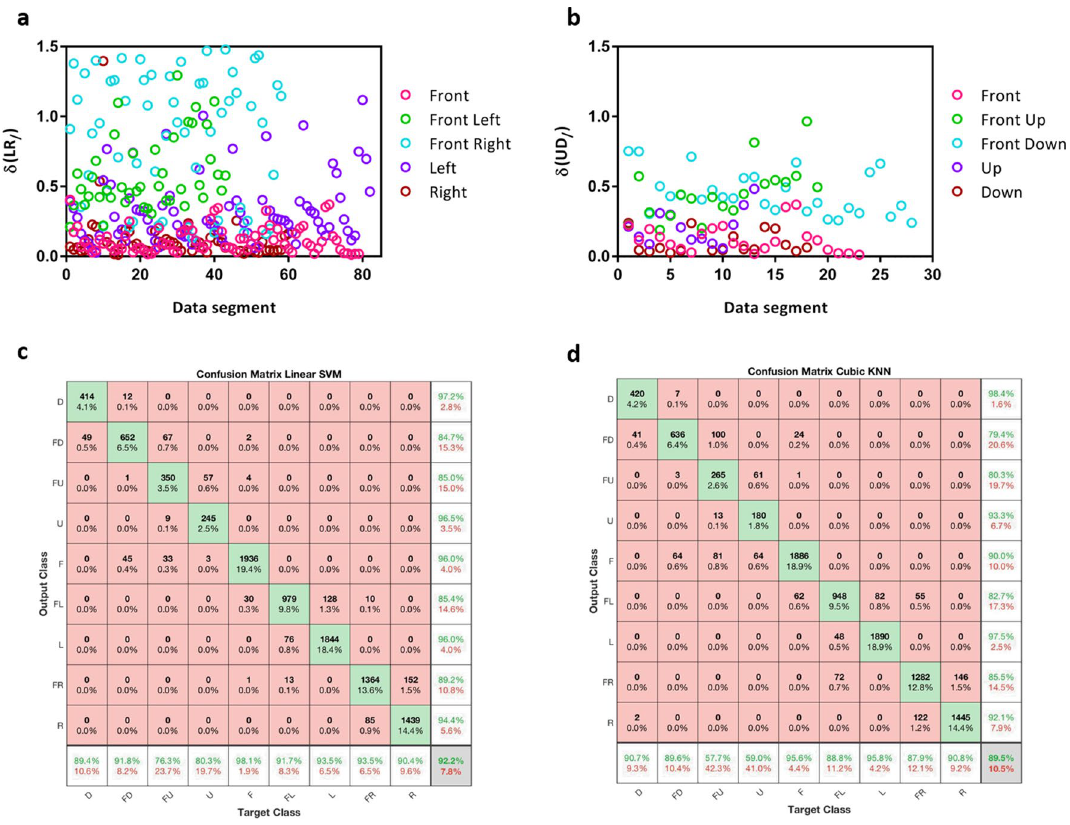
Figure 8. Extracted features and classifier result. ( a ) Difference between maximum and minimum value for horizontal motion range “/” sensor ( b ) Difference between maximum and minimum value for vertical motion